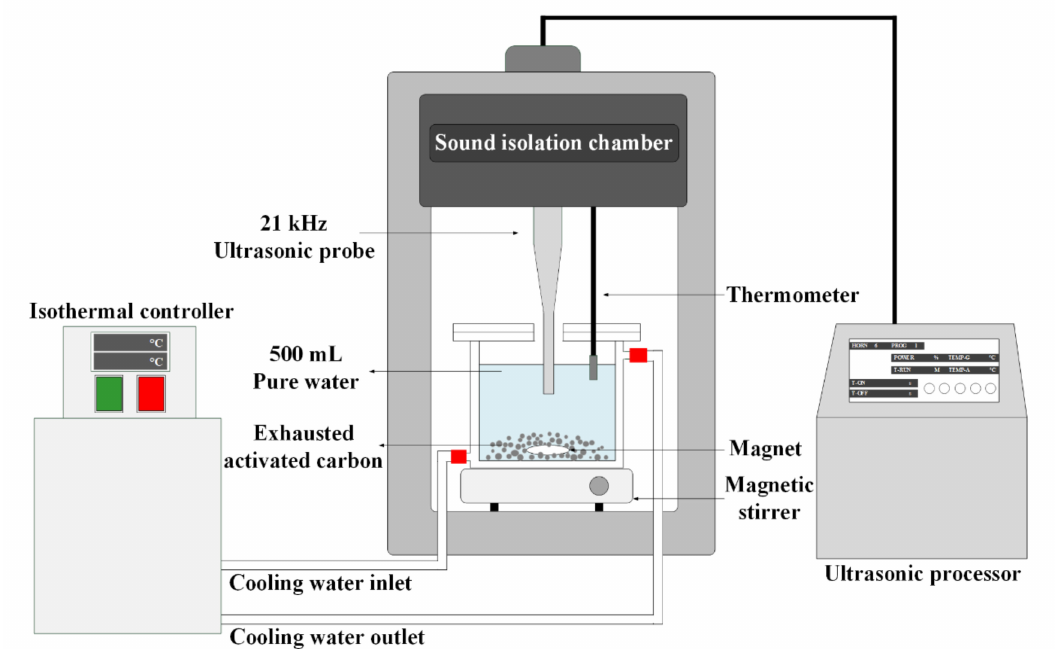
Figure 1. Experimental setup for ultrasonic regeneration of exhausted activated